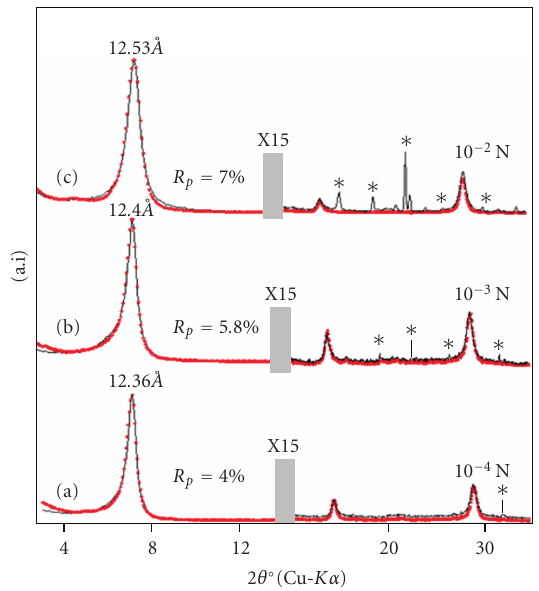
Figure 1: Best agreement between experimental (—) and the- oretical ( ∗∗∗ ) XRD patterns obtained for decreasing normality (i.e., 10 − 2 N(c), 10 − 3 N(b) and 10 − 4 N(a)) in the case of (0.5Cu 2+ and 0.5Pb 2+ ) solutions. d 001 are given in( ˚A). Rp : goodness of fit parameter. The gray bar ( Int X15 ) indicates a modified scale factor for the high-angle region. ( ∗ ): Laurionite (PbOHCl) pat ref 74-